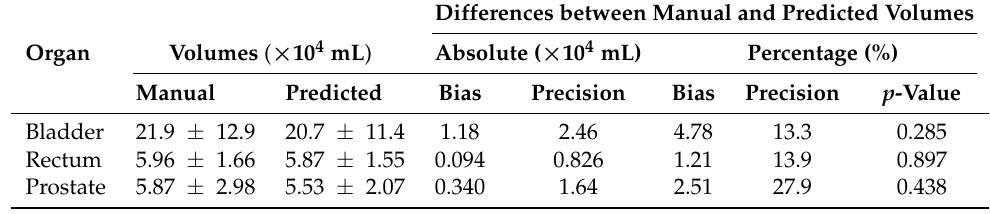
Figure 5. Comparison of manual, 3D U-net, and morphons’ DIR-based segmentation for a representative patient. Each column corresponds to a slice of the same CBCT scan. Dark colors represent reference segmentations (both second and third rows), while light colors show 3D U-net segmentation (second row) and morphons’ DIR-based segmentation (third row). The predicted bladder, in pink, has a DSC of 0.940 (U-net) and 0.864 (morphons); rectum, in light green, has a DSC of 0.791 and 0.759; prostate, in light blue, has a DSC of 0.780 and 0.730. Table 3. Absolute and relative differences between manual and predicted organs volumes. p -values are calculated using a one-sample t -test on percentage differences. Differences between Manual and Predicted